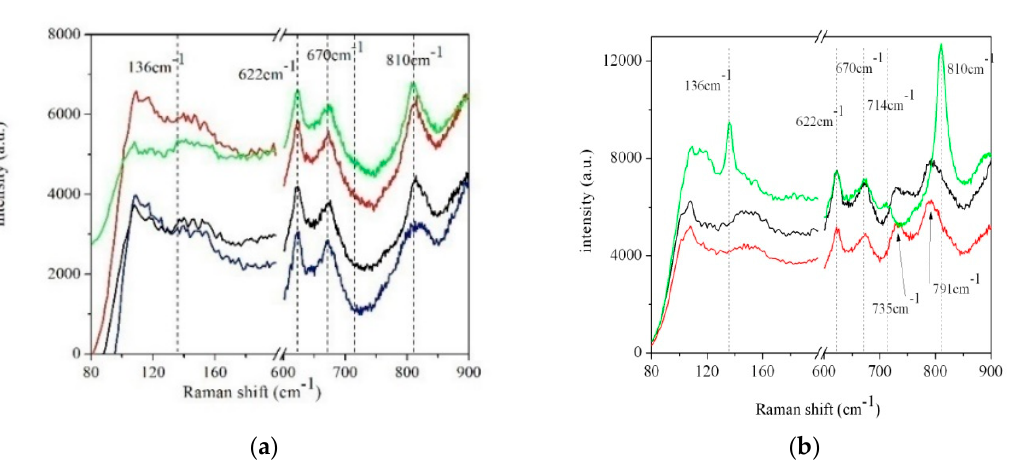
Figure 6. Raman spectra of WO 3 and Fe-doped WO 3 films. ( a ) the black spectrum belongs WO 3 film grown at 600 °C; the blue spectrum belongs to S1 sample grown at 600 °C; the red and green spectra belong to S1 sample annealed at 700 and 720 °C, respectively. ( b ) the red spectrum belongs to S1 sample annealed at 750 °C, the green spectrum to S2 sample as-grown at 720 °C and the black spectrum to S2 sample annealed at 750 °C. Table 5. Comparison of Raman peak positions of WO 3 film and S1, S2 samples (Fe-doped WO 3 ). Samples